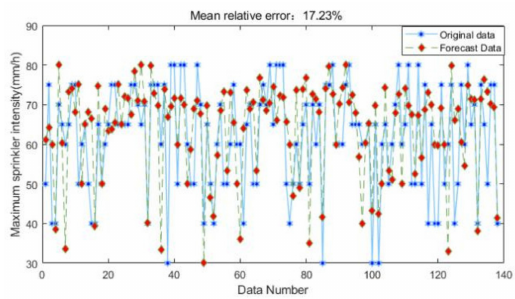
Figure 11. The smoothness parameter of the GRNN is